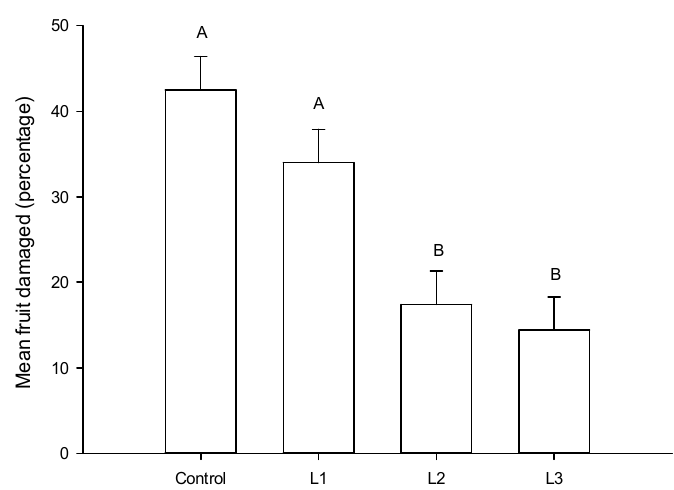
Figure 2. Mean ( ± SEM) percentage of tomato fruit damaged by Frankliniella occidentalis when first (L1), second (L2) and third (L3) instar larvae of Chrysoperla comanche or Chrysoperla externa were in the tomato plant. Original data are presented. Error bars are SEM. Bars followed by the same letter are not significantly different (Holm–Sidak, p > 0.05).